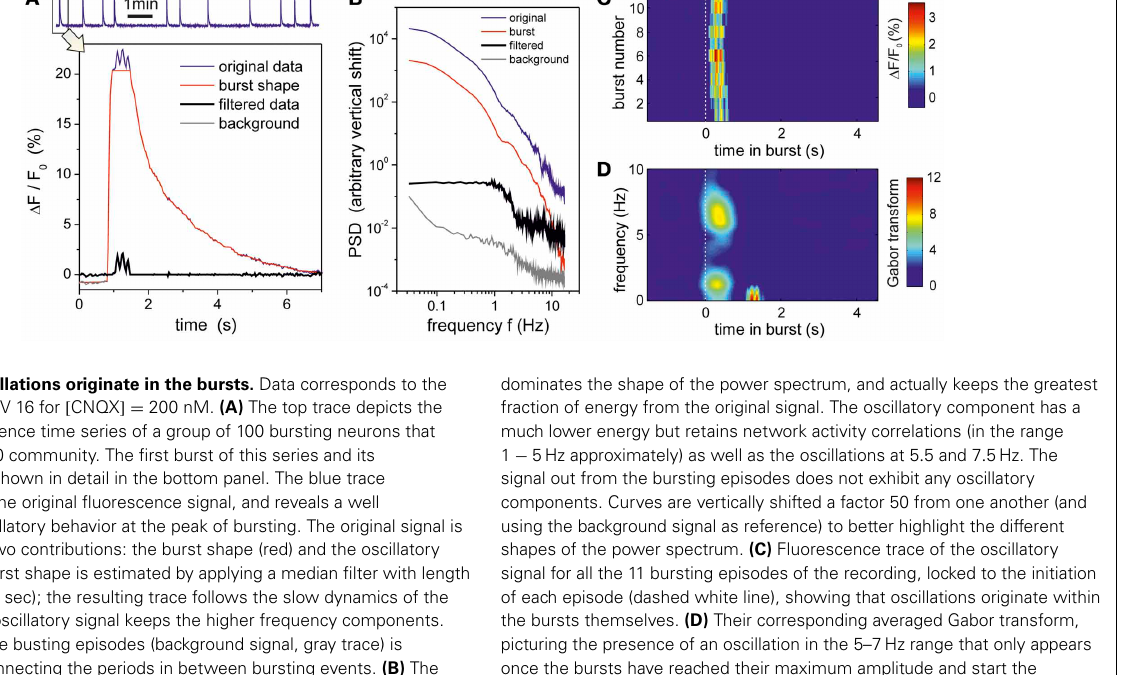
dominates the shape of the power spectrum, and actually keeps the greatest fraction of energy from the original signal. The oscillatory component has a much lower energy but retains network activity correlations (in the range 1 − 5Hz approximately) as well as the oscillations at 5 . 5 and 7 . 5Hz. The signal out from the bursting episodes does not exhibit any oscillatory components. Curves are vertically shifted a factor 50 from one another (and using the background signal as reference) to better highlight the different shapes of the power spectrum. (C) Fluorescence trace of the oscillatory signal for all the 11 bursting episodes of the recording, locked to the initiation of each episode (dashed white line), showing that oscillations originate within the bursts themselves. (D) Their corresponding averaged Gabor transform, picturing the presence of an oscillation in the 5–7Hz range that only appears once the bursts have reached their maximum amplitude and start the decaying